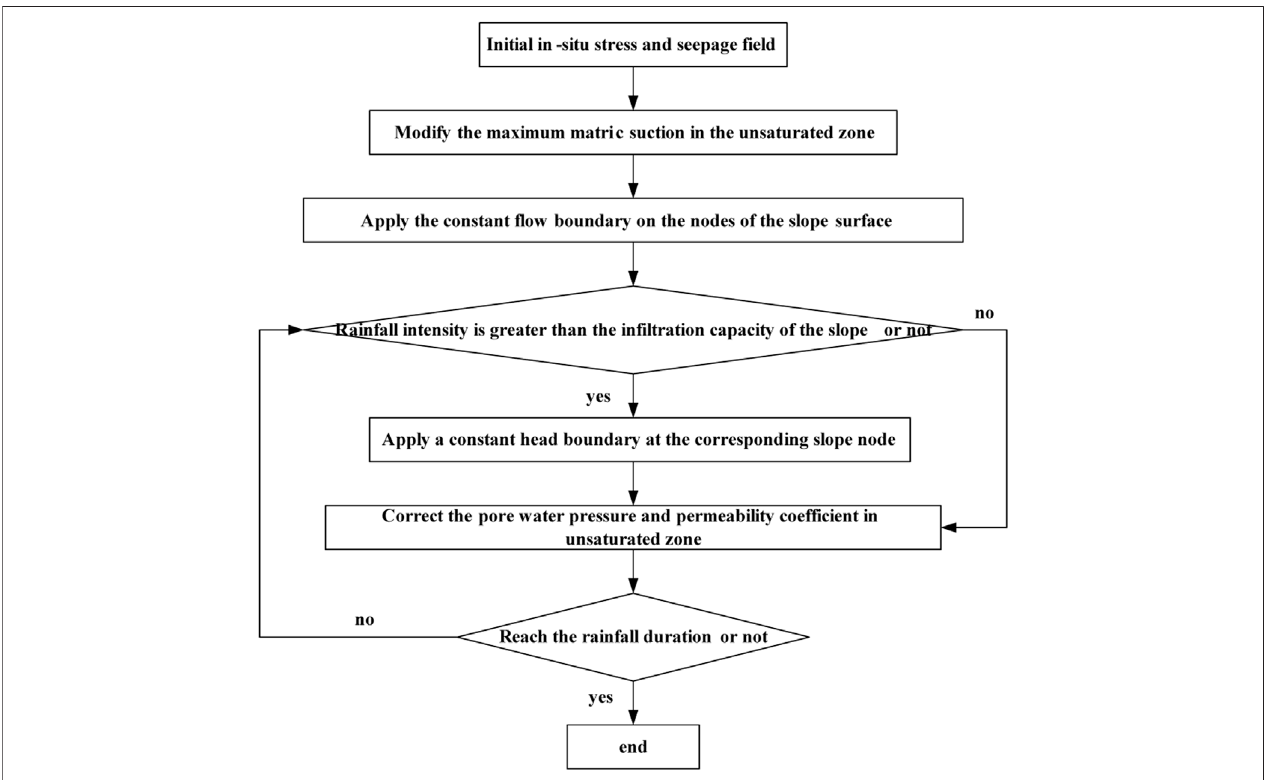
FIGURE 1 | Schematic diagram of saturated-unsaturated seepage procedure.